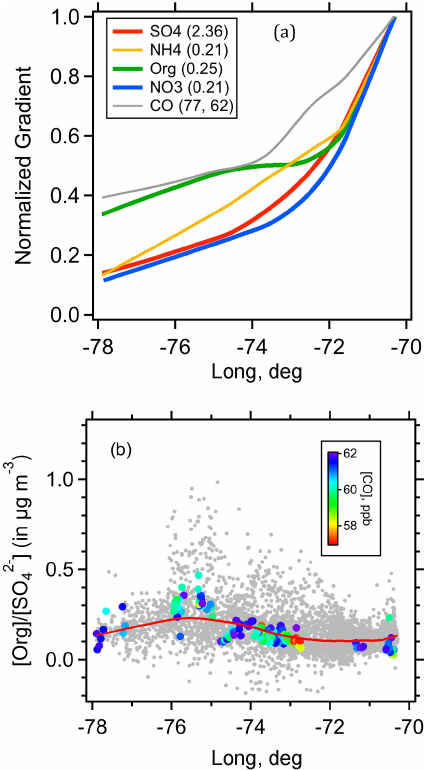
Figure 12. (a) Normalized composite longitudinal distributions of below-cloud SO 2 − , NH + , Org, NO − , and CO. The highest concen- 4 4 3 trations with which the LOWESS lines are normalized to are shown in the parentheses, all in µgm − 3 except for CO which is in ppb. The estimated background CO concentration is also indicated. (b) De- pendence of [Org]/[SO 2 − ] ratio on longitude, where the solid red 4 line represents the LOWESS smooth of the